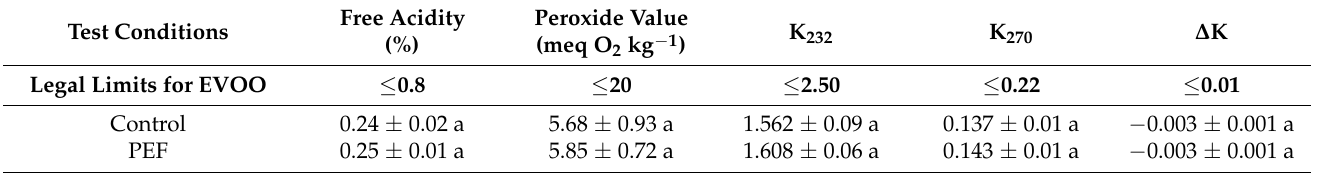
Table 2. Legal quality parameters of EVOOs according to EU regulation [26].